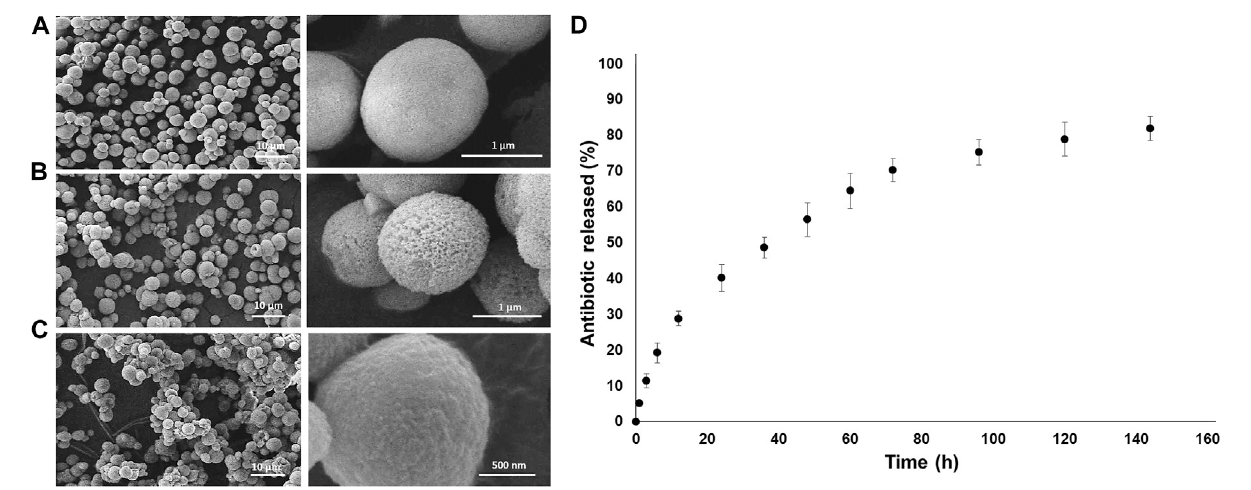
FIGURE 3 | SEM Images of the MP as prepared (A) , after eight layers (B) and after 14 layers (C) . In vitro release data from the LbL-functionalized MPs (D) . Each data point represents the mean ± standard deviation over a set of six tested samples.